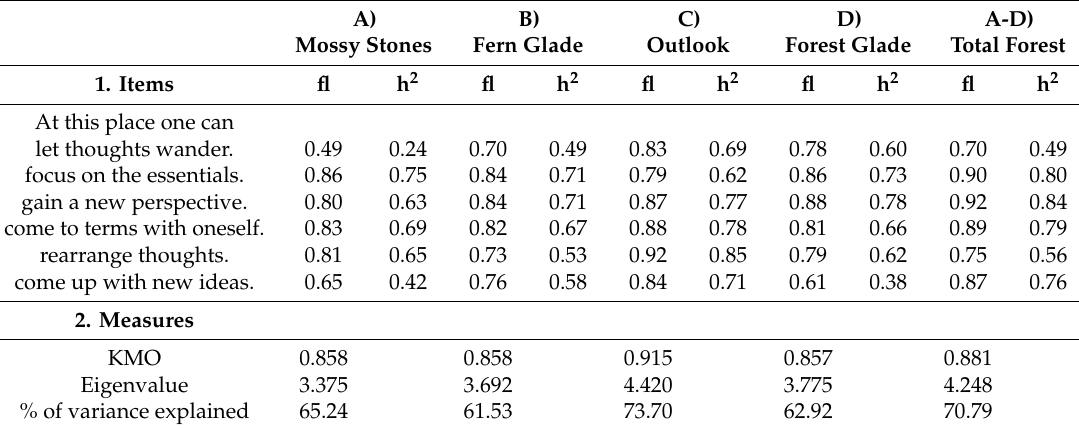
Table 3. Factor analysis of the Widen One’s Mind (WOM) scale at the places and the forest.